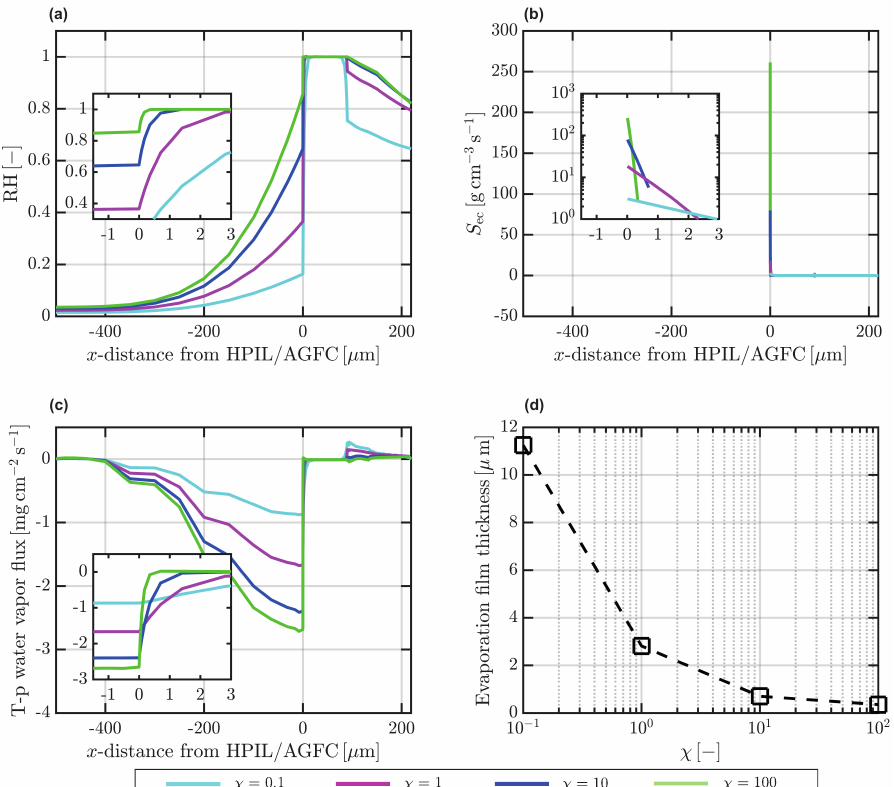
Figure 8. Influence of α ec as a function of χ on the through-plane profile of ( a ) RH, ( b ) evaporation source term, ( c ) through-plane water vapor flux and ( d ) evaporation film thickness (determined by the layer thickness of positive evaporation